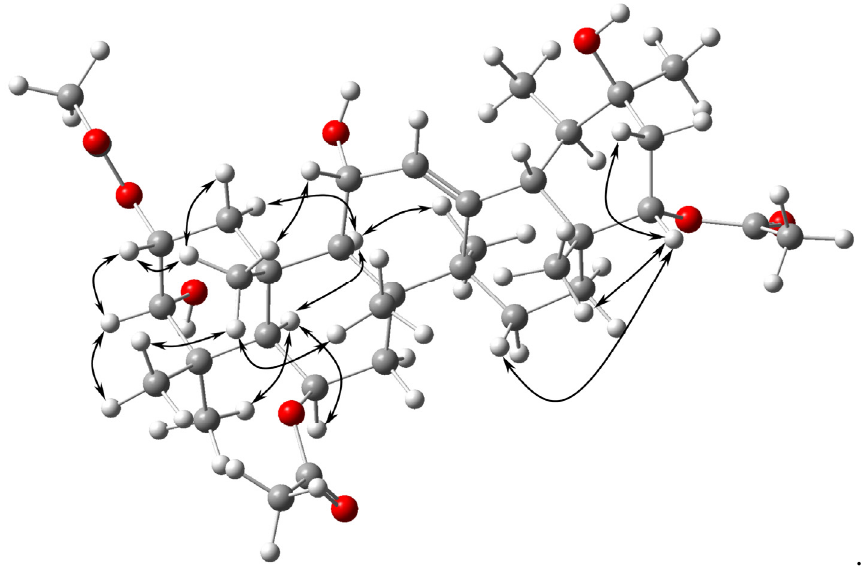
Figure 3. Key NOESY correlations for 2 .